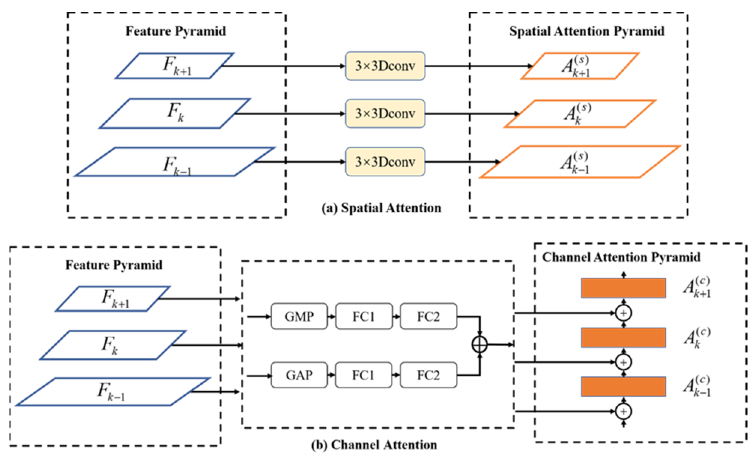
Figure 4. Spatial attention and channel attention modules.